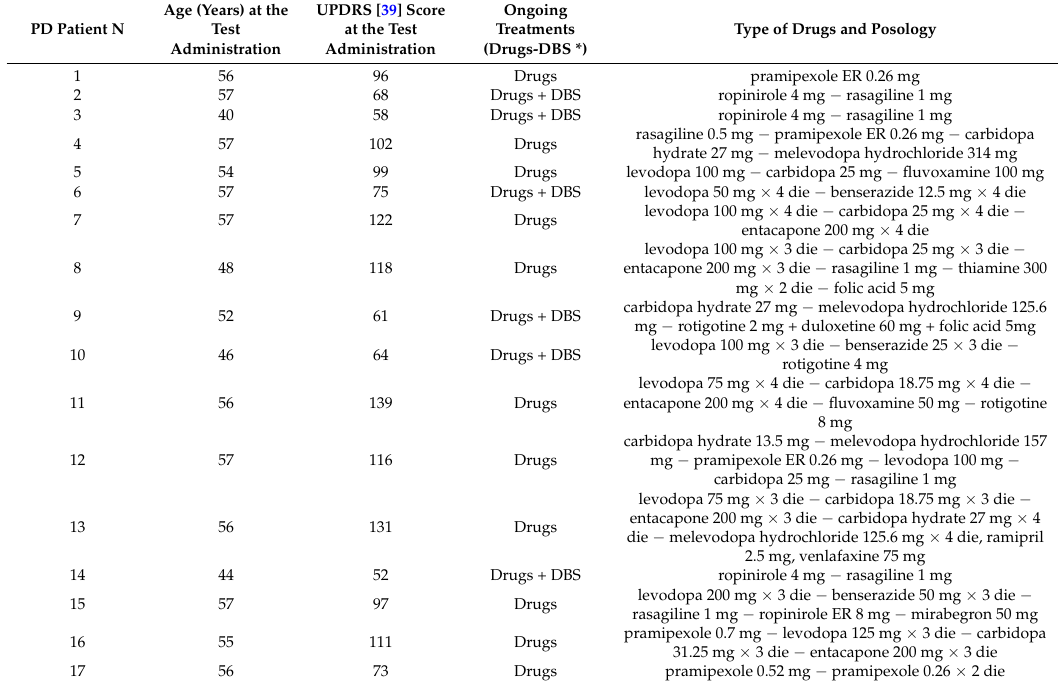
Table 2. Age, Unified Parkinson’s Disease Rating Scale (UPDRS) [39] score and ongoing treatments of PD